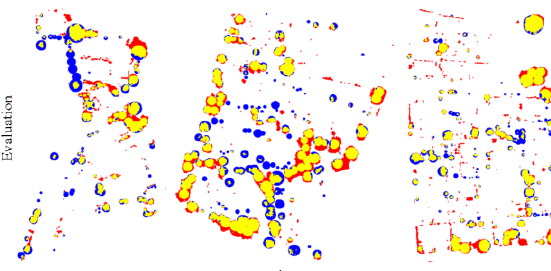
Figure 7. In this figure yellow pixels are True Positives, red pixels are False Negatives and blue pixels are False